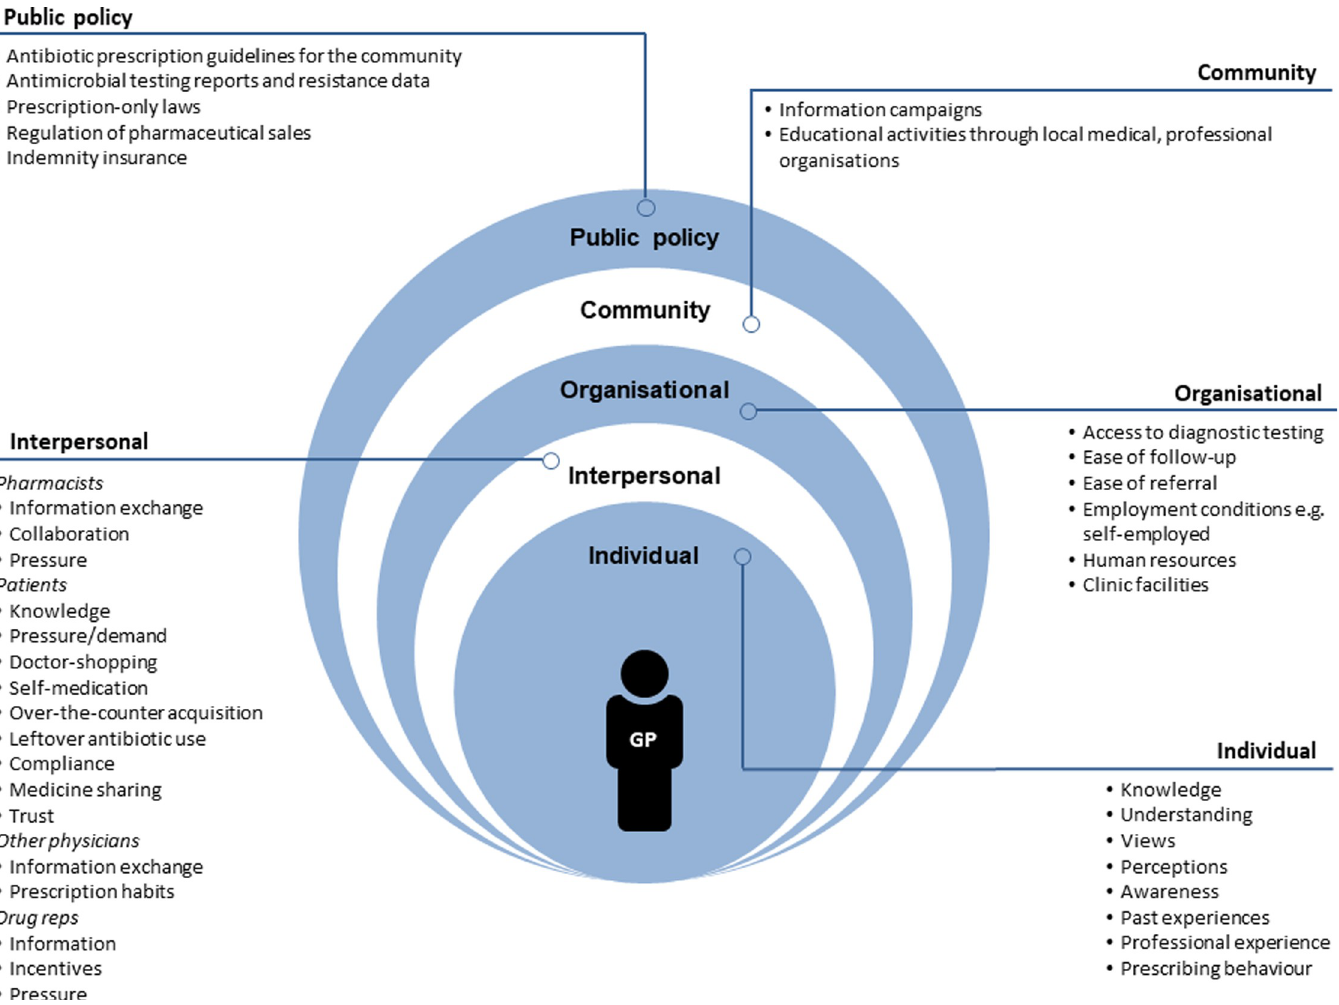
Fig 1. Overview of barriers and facilitators identified to have an impact on GPs’ antibiotic prescribing at all levels of the socioecological model.